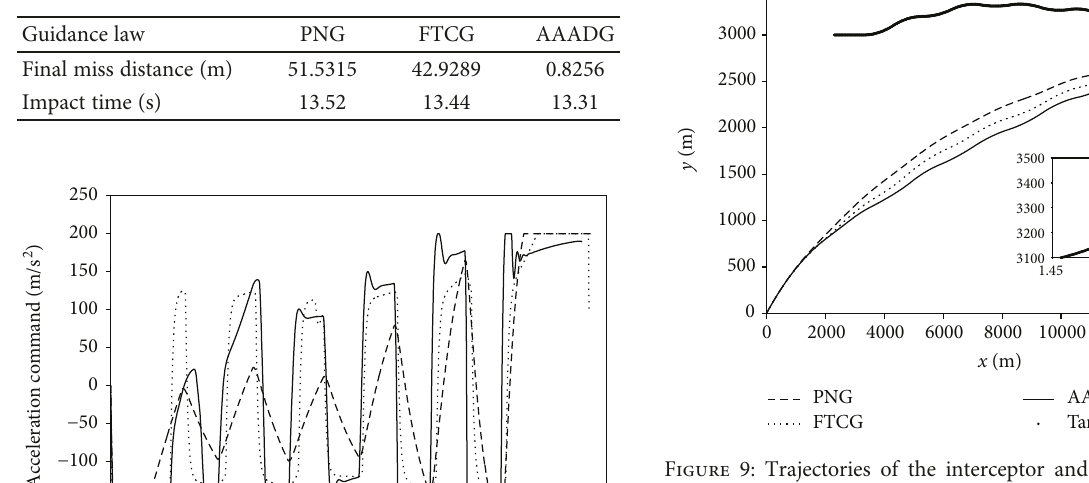
Table 2: Final miss distance and impact time.